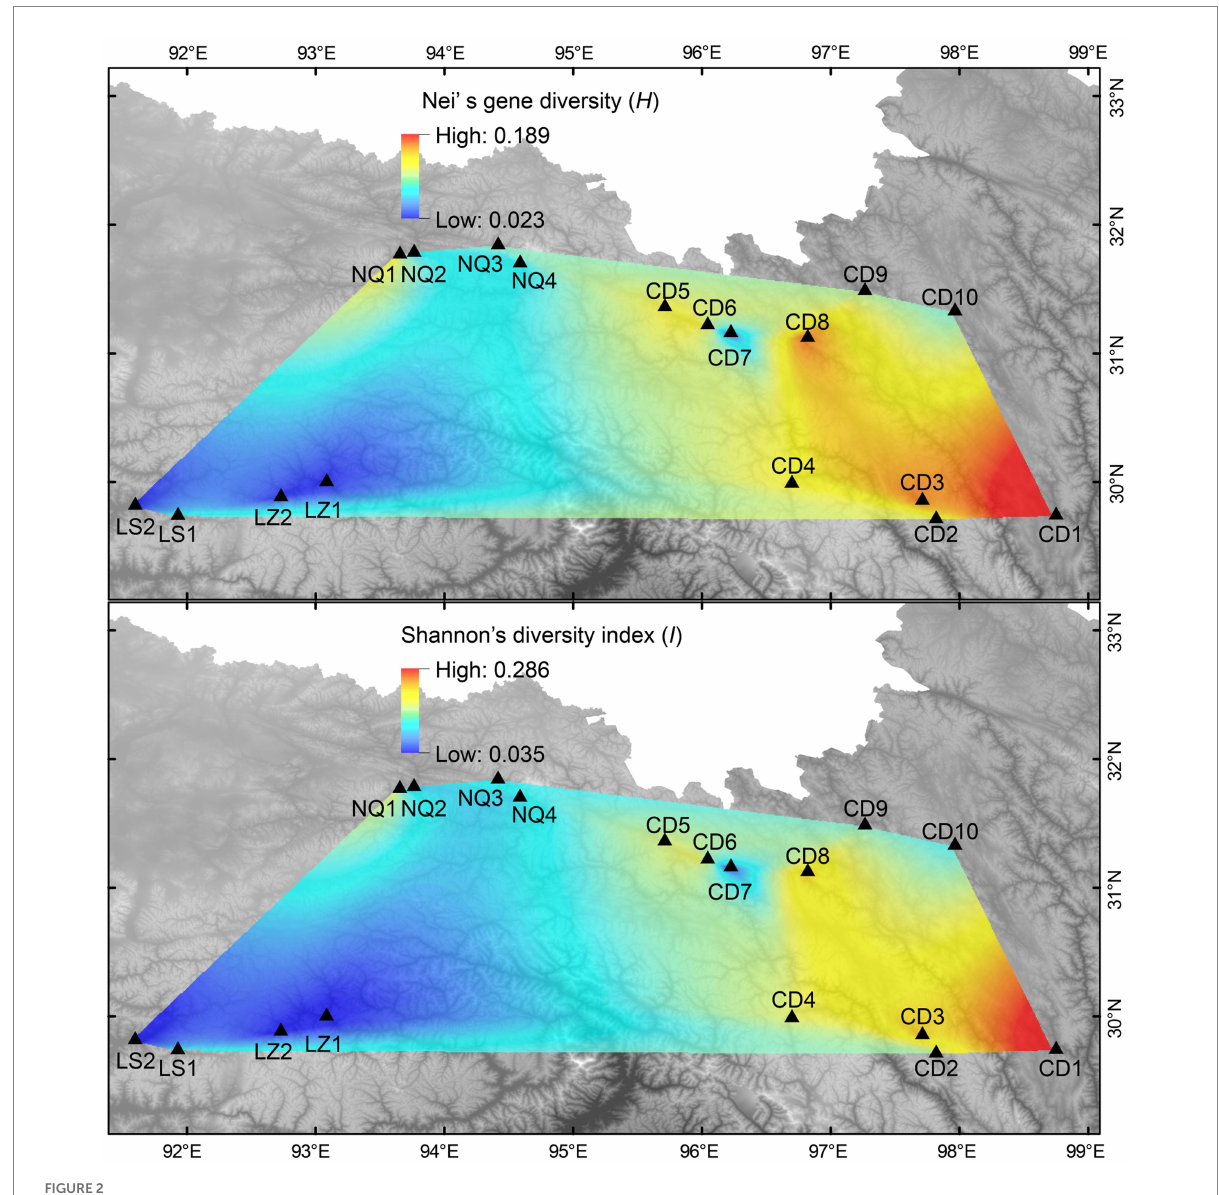
FIGURE 2 Genetic landscape for E. breviaristatus